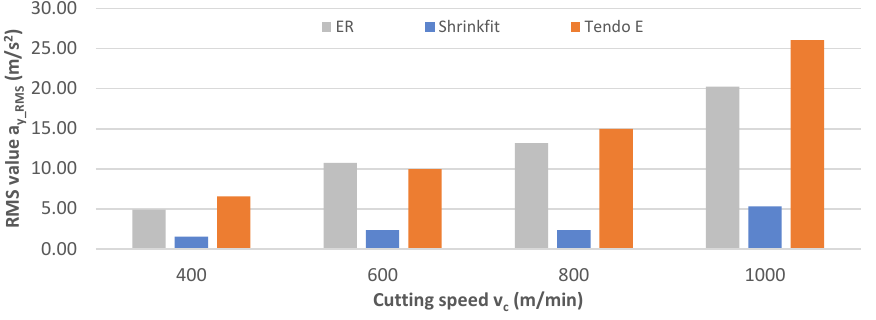
Figure 14. Impact of cutting speed v c on the rms vibration acceleration value a y_RMS (f z = 0.15 mm/tooth, a p = 6 mm).